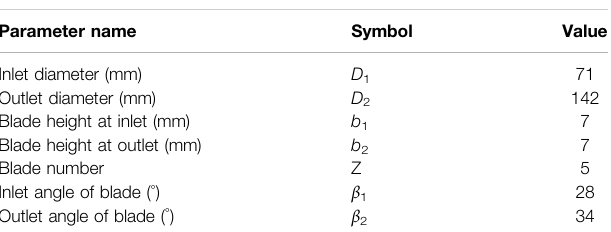
TABLE 1 | Impeller geometry. Parameter